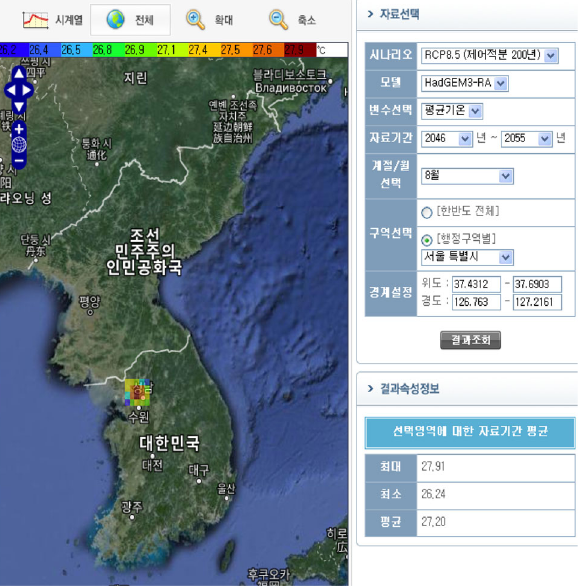
Fig. 12 Application of RCP